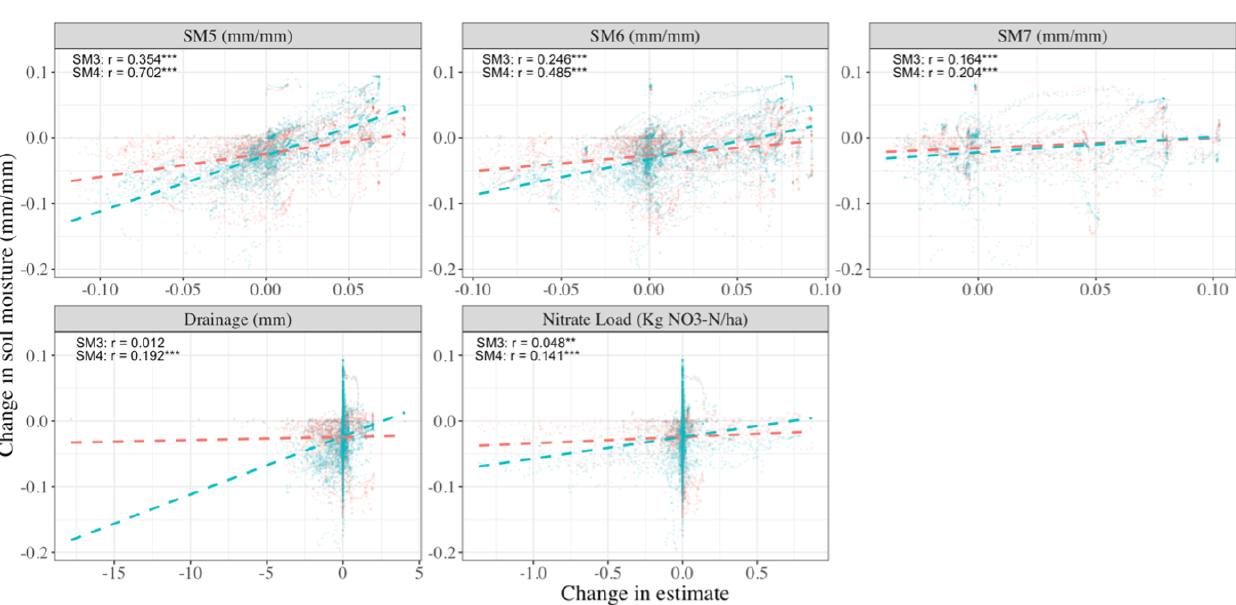
Figure A1. Scatterplots comparing change (i.e., SDA – free model) in mean SM5, SM6, SM7, daily drainage, and daily NO 3 leaching estimates with change in mean SM3 and SM4 estimates at each analysis time step. For each variable combination, the least squares regression line is demonstrated by a dashed line and the Pearson correlation coefficient is displayed. Asterisks denote significant coefficient values ( ∗∗ indicates p value < 0.01, and ∗∗∗ indicates p value ∼